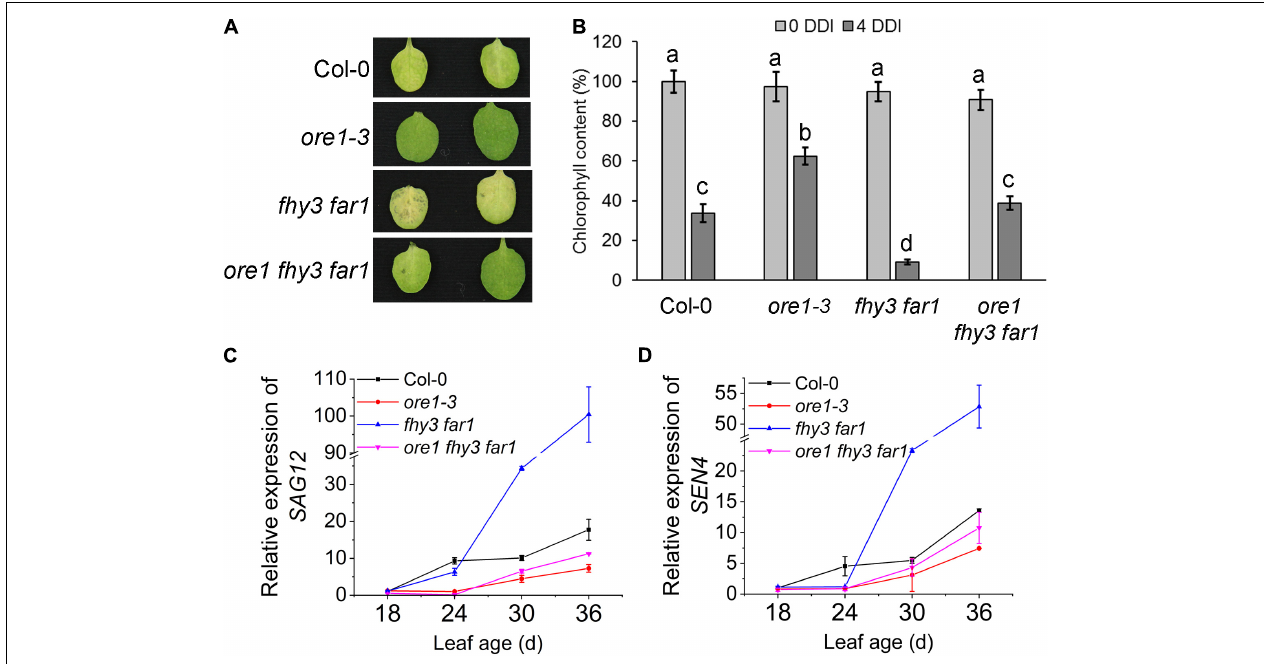
FIGURE 3 | ORE1 acts downstream of FHY3 and FAR1 . (A) The senescence phenotypes of the detached leaves of 4-week-old Col-0, ore1-3 , fhy3 far1, and ore1 fhy3 far1 plants incubated under darkness for 4 days. The ore1-3 mutant was described in Supplementary Figure 5 . (B) The chlorophyll content of the fourth leaves in (A) . Error bars represent SD ( n = 6). Letters indicate significant differences by two-sided LSD test ( p < 0.05). (C,D) Quantitative RT-PCR analysis of SAG12 (C) and SEN4 (D) expression in the fourth leaves of Col-0 and fhy3 far1 at the indicated leaf age. Error bars represent SD ( n =